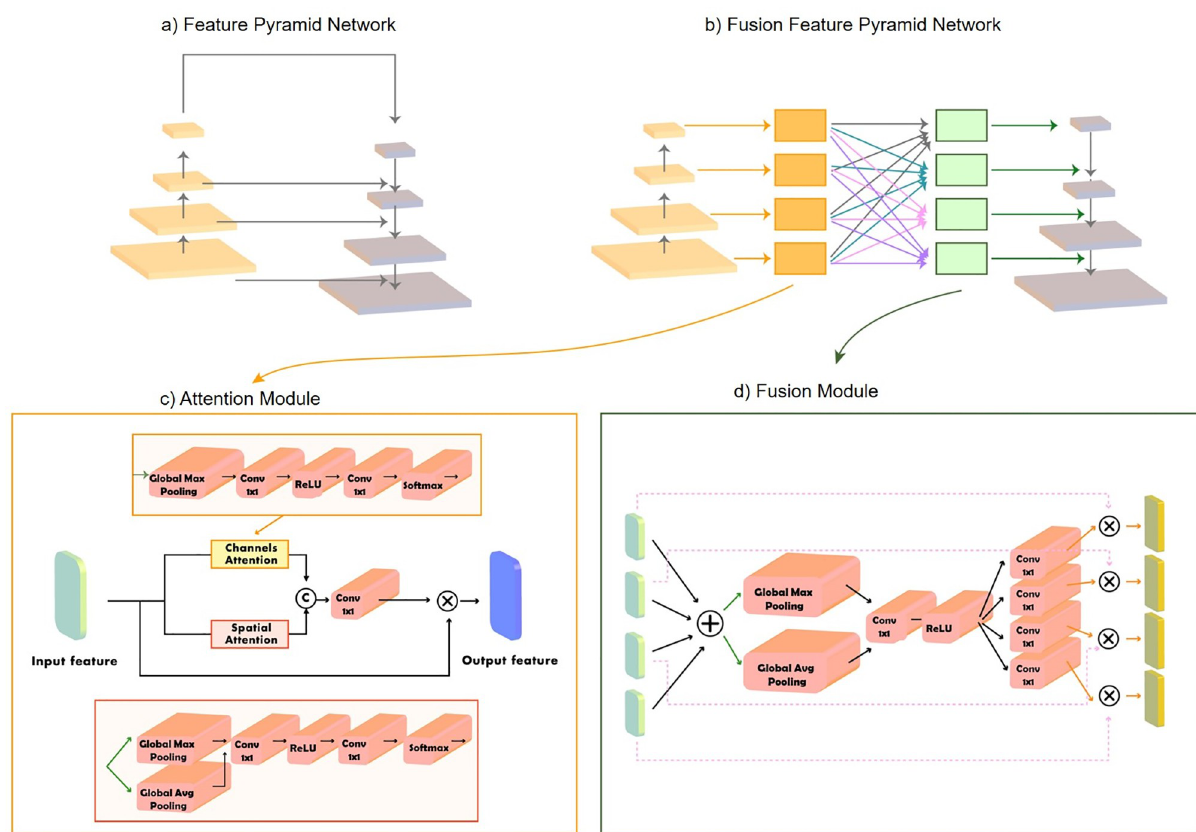
Fig 4. Comparison of the architecture of the feature pyramid network (FPN) and the proposed FusionFPN: a) architecture of the FPN, b) architecture of FusionFPN, c) attention module architecture, and d) fusion module architecture.